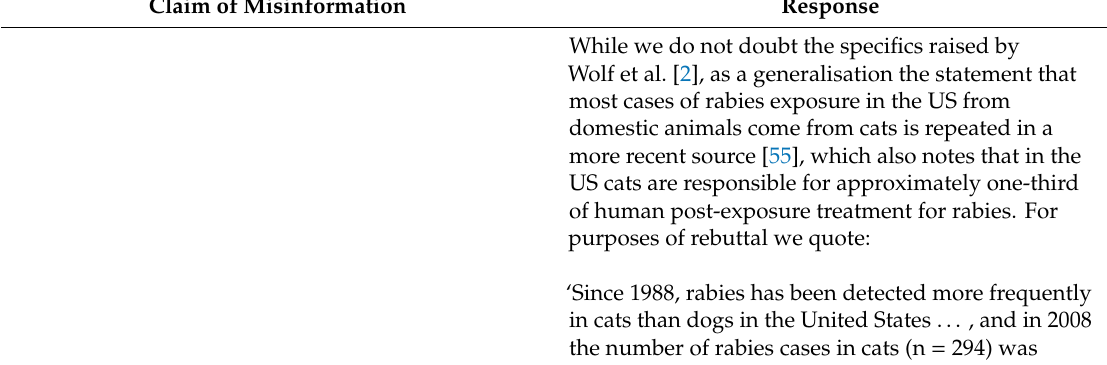
Table 3. Responses to claims of misinformation in Crawford et al. (2019a). Claim of